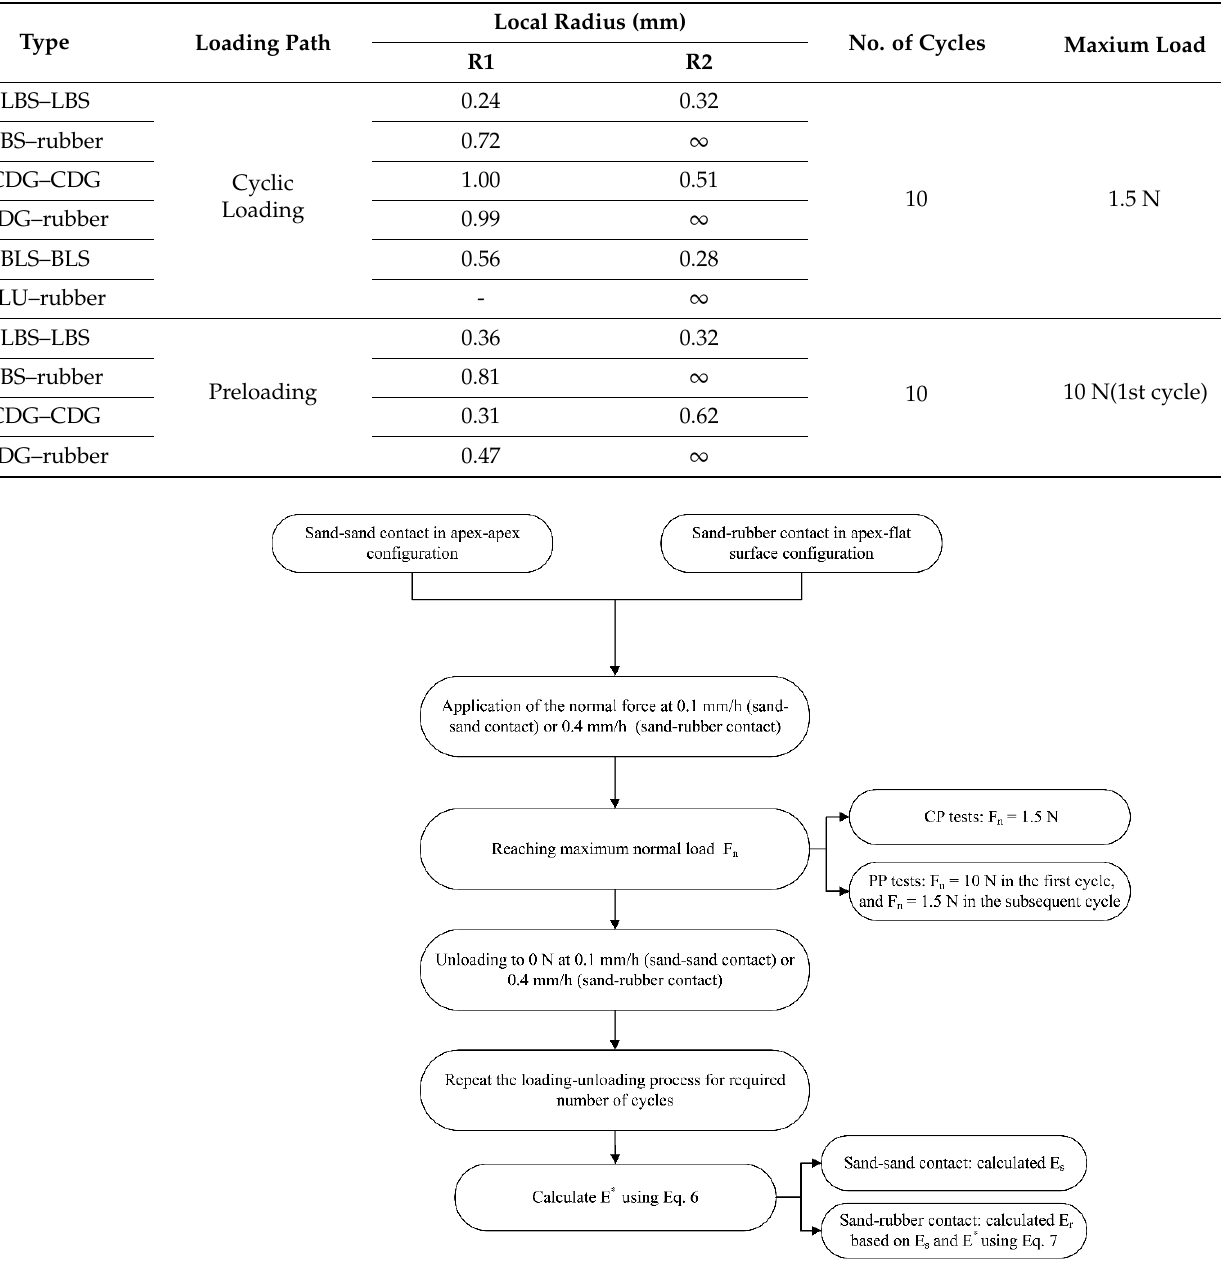
Figure 6. Flowchart explaining the different steps during the experiments and data analysis.